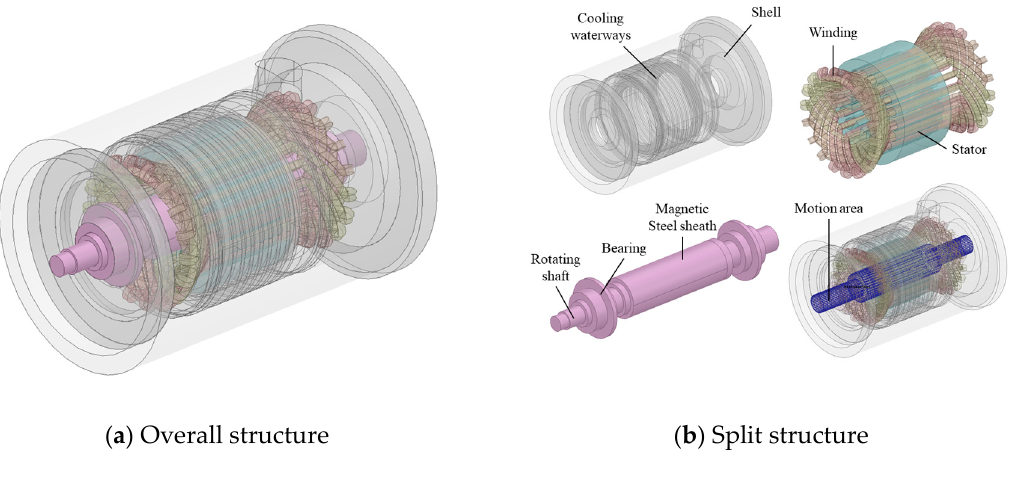
Table 2. Main g eometric parameters of motor.